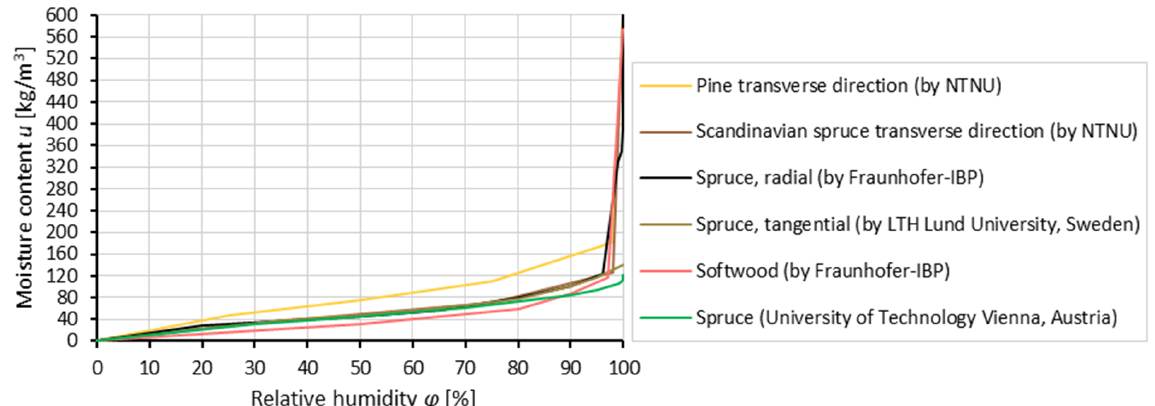
Figure 3. Moisture storage functions of the wood species that were tested for the selection of proper material properties for the two case studies. The data derive from the WUFI ® database. Table 1. Inputs, outputs, and origin of the measurements to validate the outputs of the simulated hygrothermal perfor- mance of selected building components.